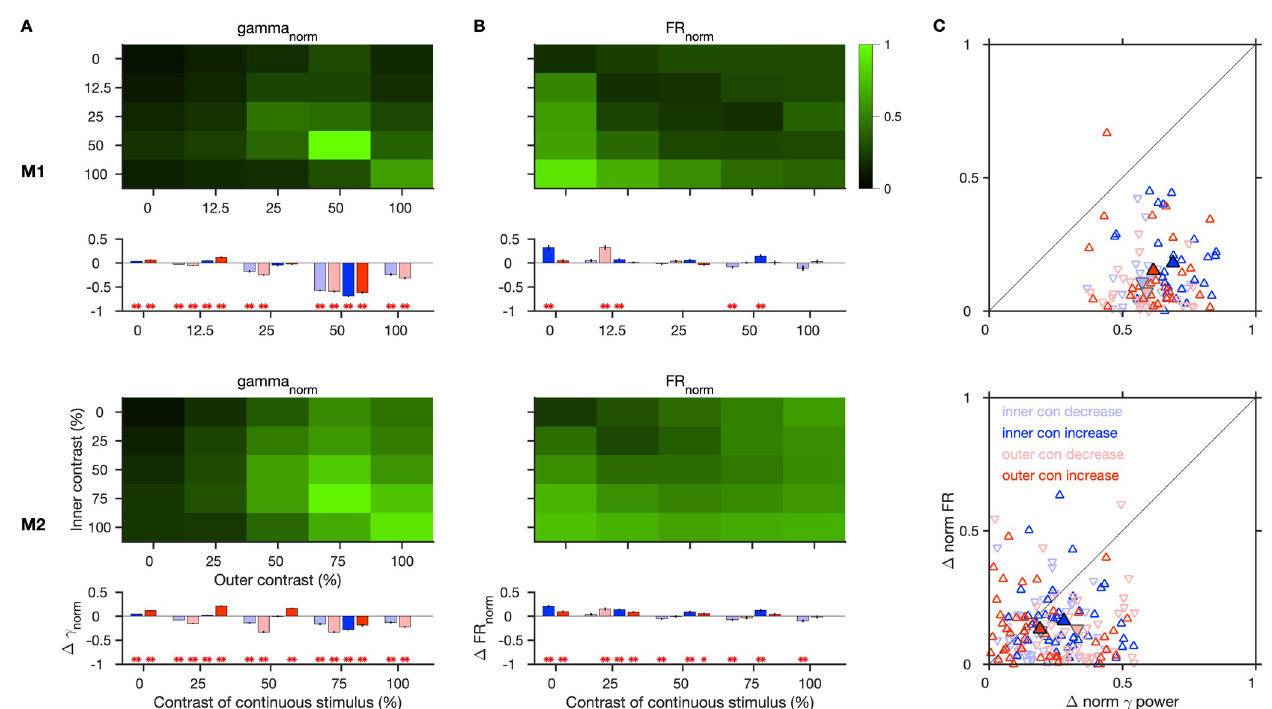
Fig 6. Effect of contrast discontinuity on gamma and firing responses. (A) Normalized gamma power and (B) normalized firing rate during the stimulus period for different outer and inner contrast conditions, for the same electrodes as in Fig 5C, for M1 (top) and M2 (bottom). The corresponding effect of change in contrast from a continuous stimulus is shown below each. The bar graphs denote the change for a step change (decrease or increase) in contrast occurring in either the inner or the outer grating, from a continuous stimulus whose contrast is indicated on the x-axis. Asterisks indicate its statistical significance ( �� for p < 0.01, � for p < 0.05, WSR test). (C) Magnitude of change in normalized gamma power versus normalized firing rates for the 4 smallest discontinuities from 50% contrast and 75% contrast continuous grating in M1 and M2, respectively. Larger and bordered data points show the mean across sites. Figure data are located at https://doi.org/10.5281/zenodo.6523772. M1, Monkey 1; M2, Monkey 2; WSR, Wilcoxon signed rank.